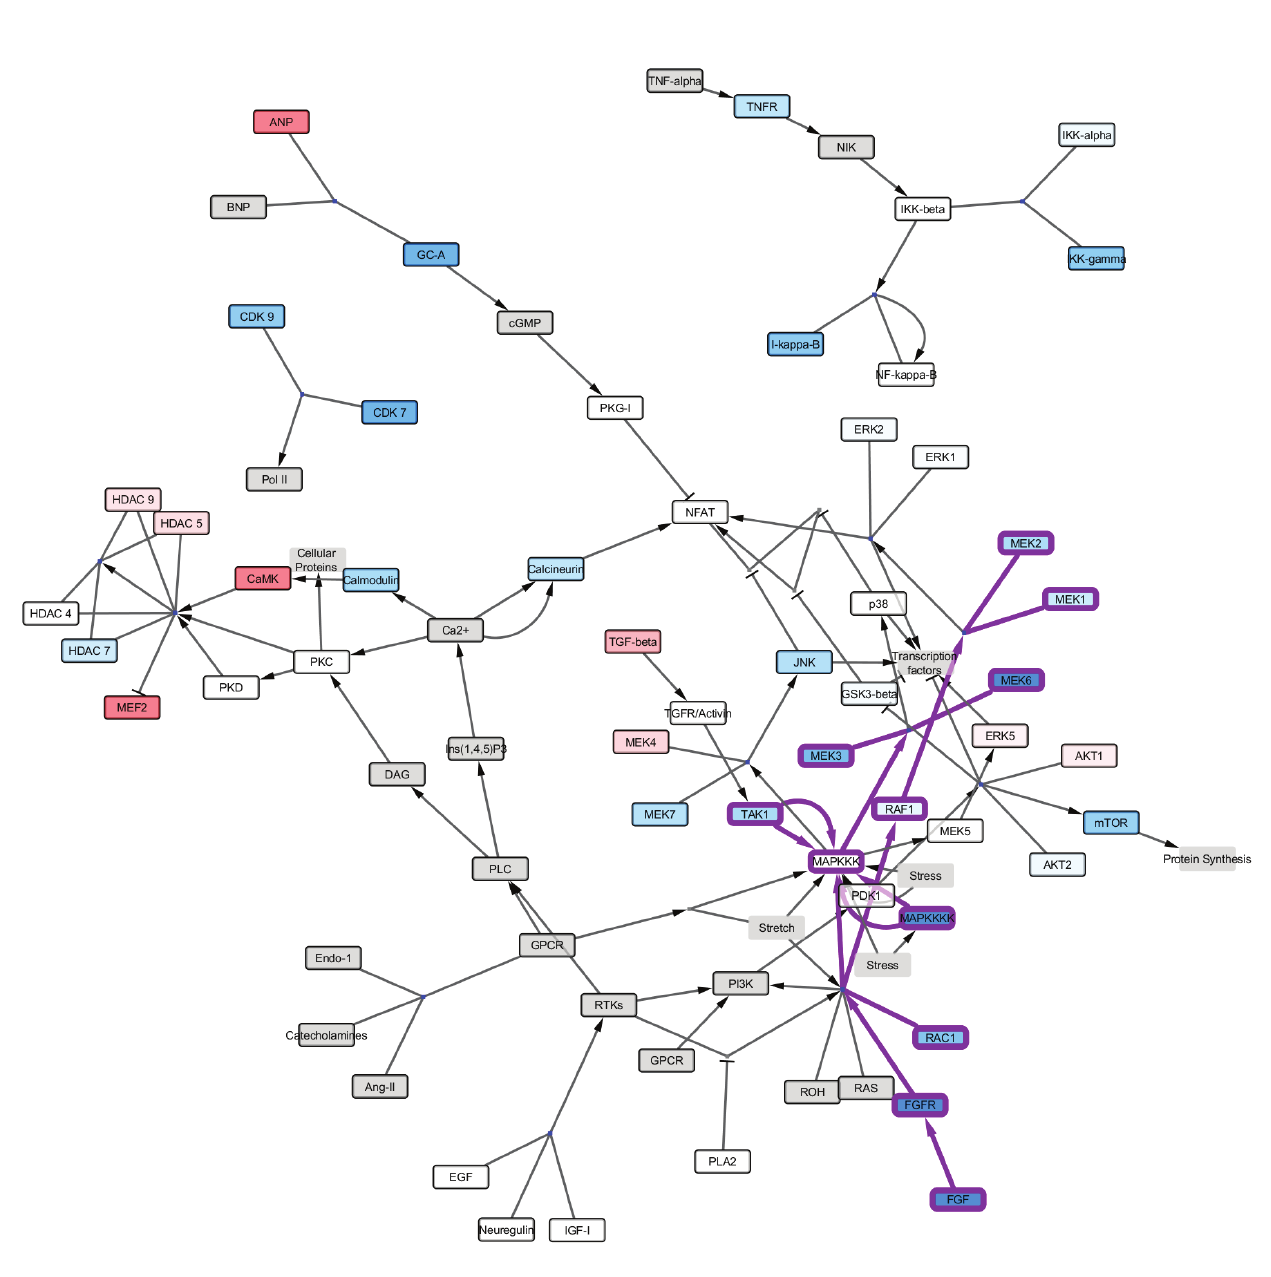
Supplementary Figure 5. Figure 2D in the WikiPathways App paper including all graphical details, e.g.